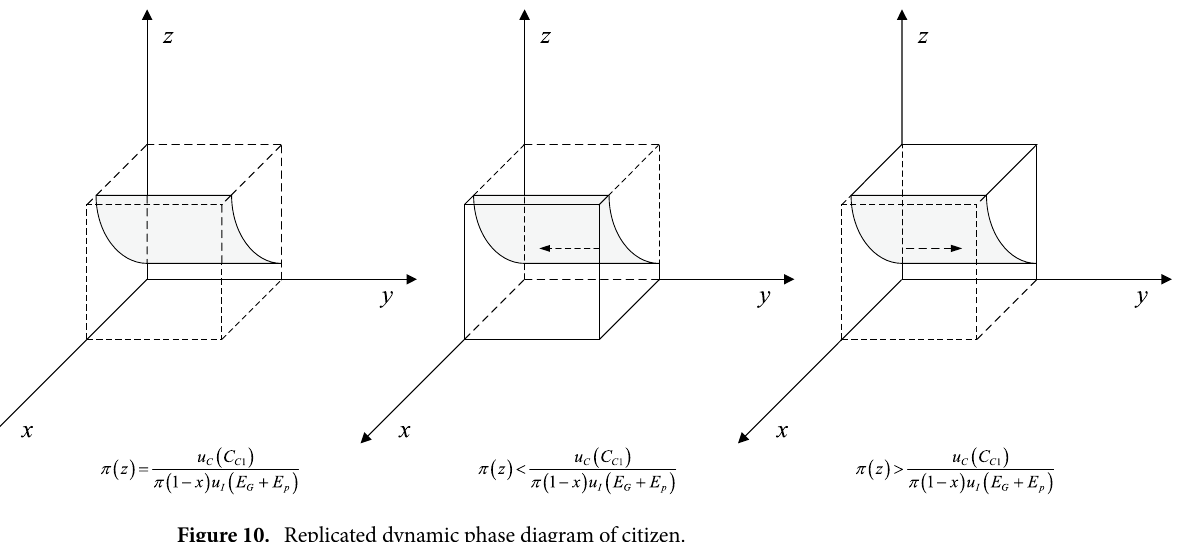
Figure 10. Replicated dynamic phase diagram of